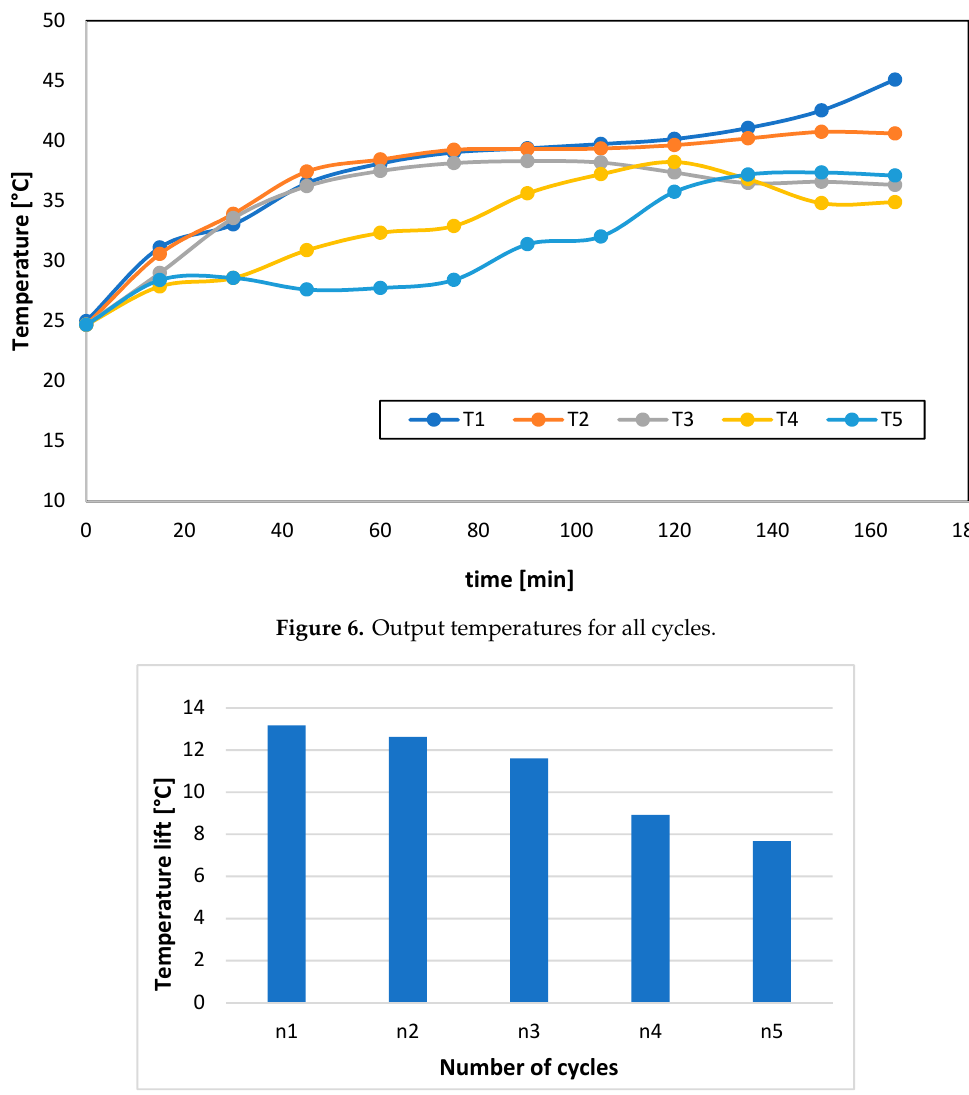
Figure 7. Average temperature lift plotted against the number of cycles.